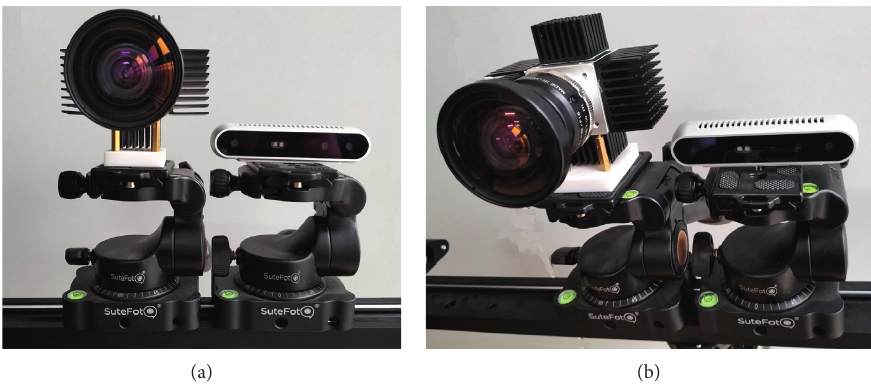
Figure 3: The camera system used in this experiment. (a) The front. (b) The